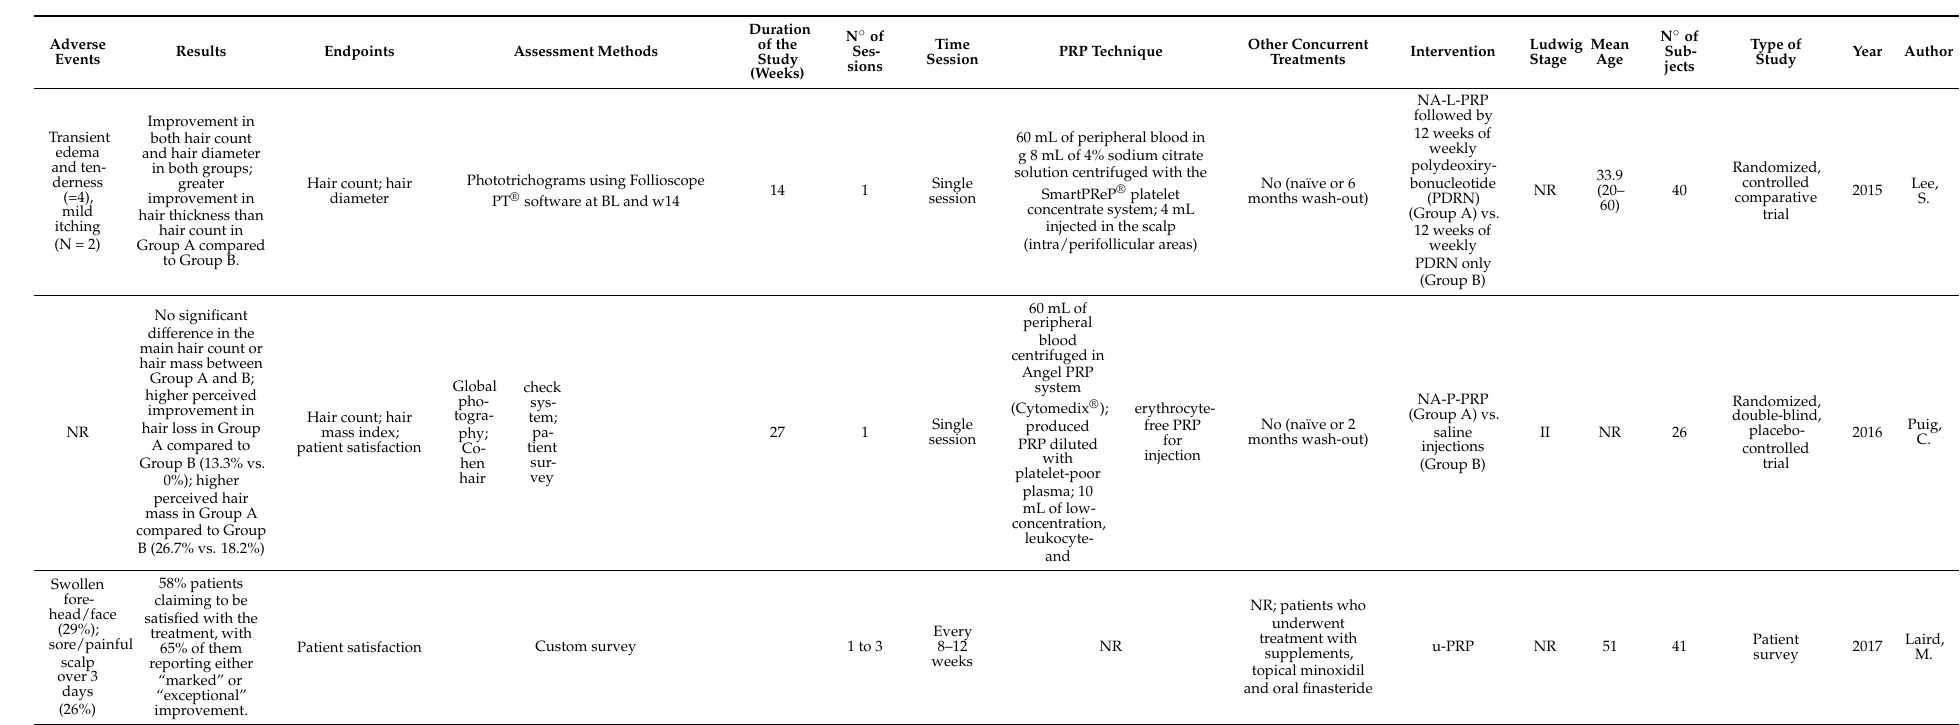
Table 1. Clinical studies consistent with our research. Study design, number of enrolled patients, Ludwig score, type of intervention, eventual concurrent other treatments, PRP preparation process and technique, number and times of sessions, duration of the study, assessment criteria, endpoints, results, time of follow-up, and reported side effects are described. NR = Not Reported; NA-L-PRP = non-activated leucocyte platelet-rich plasma; NA-P-PRP = non-activated pure platelet-rich plasma; AA-L-PRP = activated leucocyte platelet-rich plasma; NA-PRP = non-activated platelet-rich plasma; u-PRP = not-specified platelet-rich